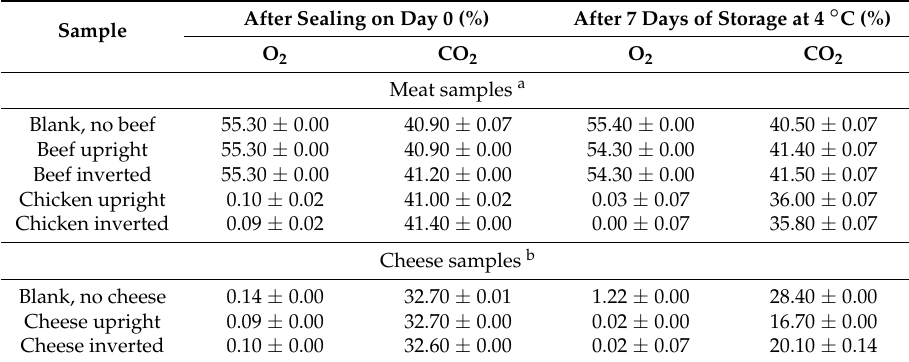
Table 3. O 2 and CO 2 levels in packs of MAP raw meat (beef and chicken) and cheese measured by Dansensor TM ( n = 2 for each reading).